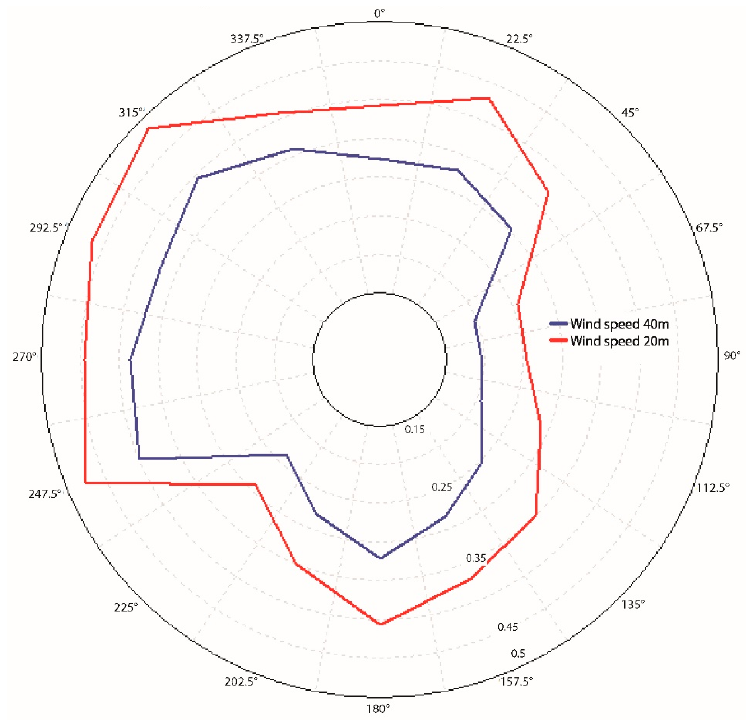
Figure 14. Representative turbulence intensity vs. wind direction. Source: generated by the software. 4.5. Contour Line Maps, Isotach Maps, and Wind Turbine Siting A contour line map, isotach map at 120 m and contour lines spaced every 5 m for the entire 3.2 software (downloaded from SRTM server).